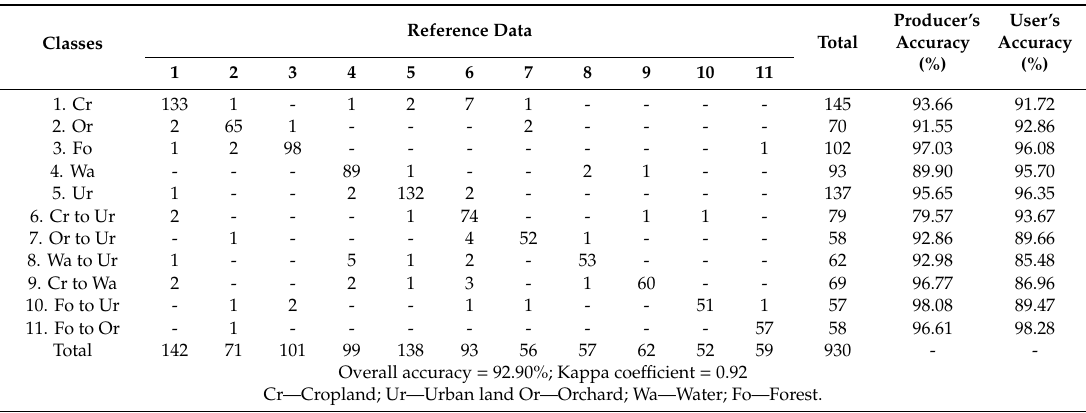
Table 3. Confusion matrix of the PCA-based method, 2006–2016.